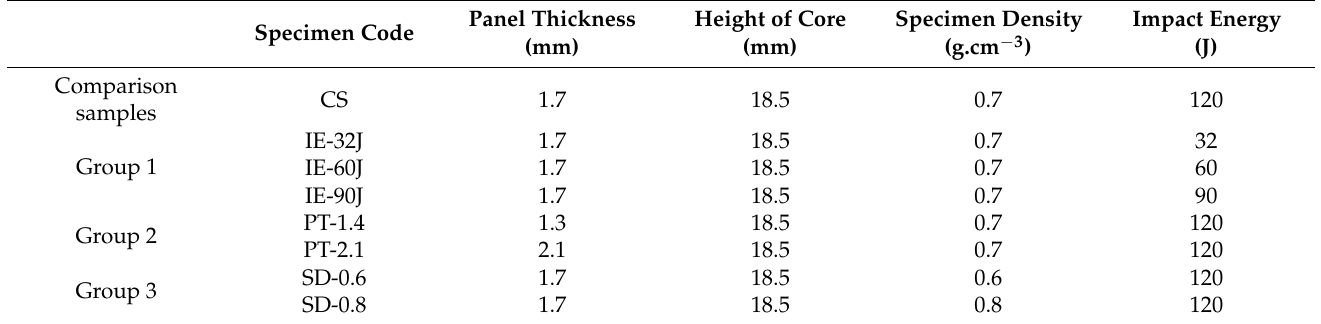
Figure 2. INSTRON 9250HV drop hammer impact tester. Table 2. Experimental design of low-velocity impact of AFS.